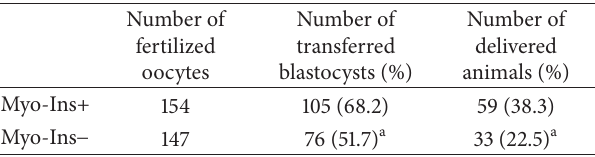
Table 1: Effect of myo-Ins on Akt phosphorylation of late preim- plantation mouse embryos.